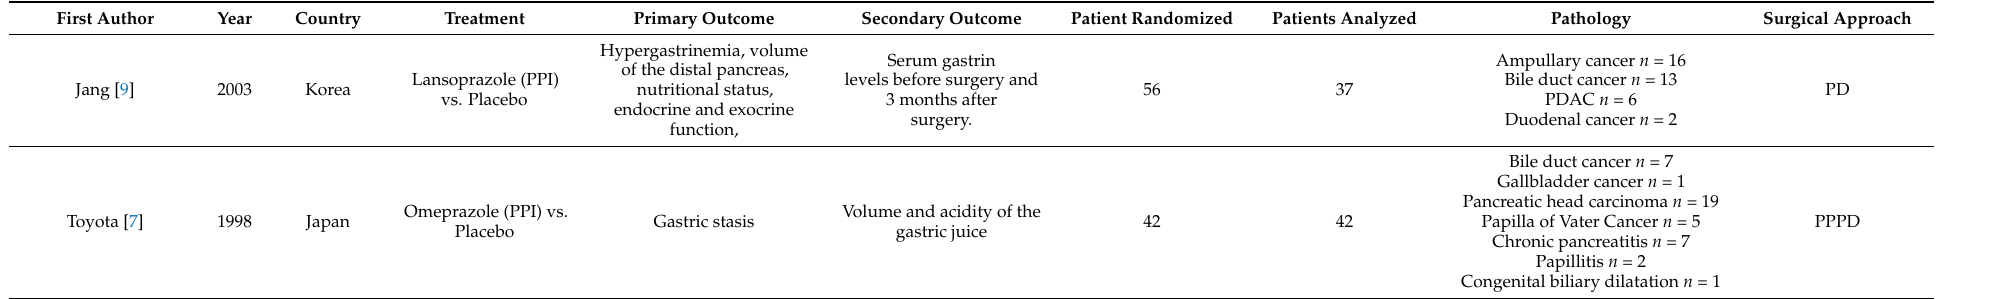
Table 4. Proton-Pump-Inhibition.